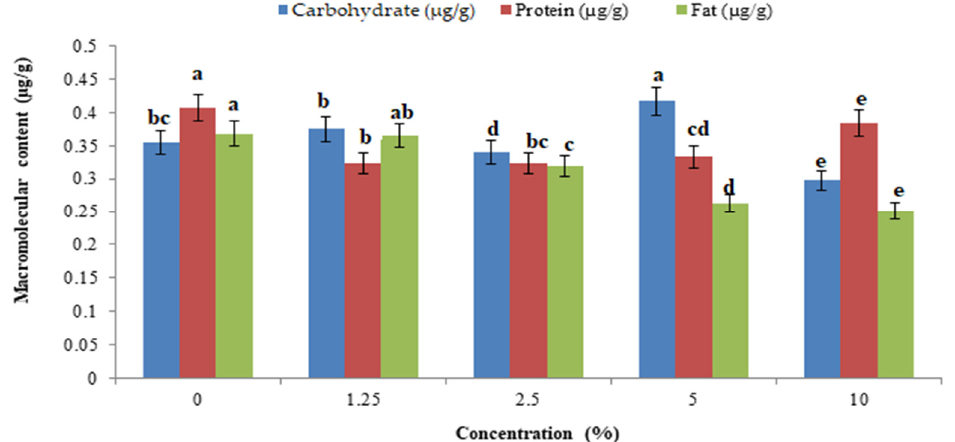
Figure 9. Whole-body carbohydrate, protein, and fat ( µ g/g) of P. solenopsis exposed to different concentrations of vijayneem. Different letters (among the same concentration for each enzyme separately) above bars indicate significantly different means according to Tukey’s test ( p < 0.05). Bars indicate the standard error (SE).